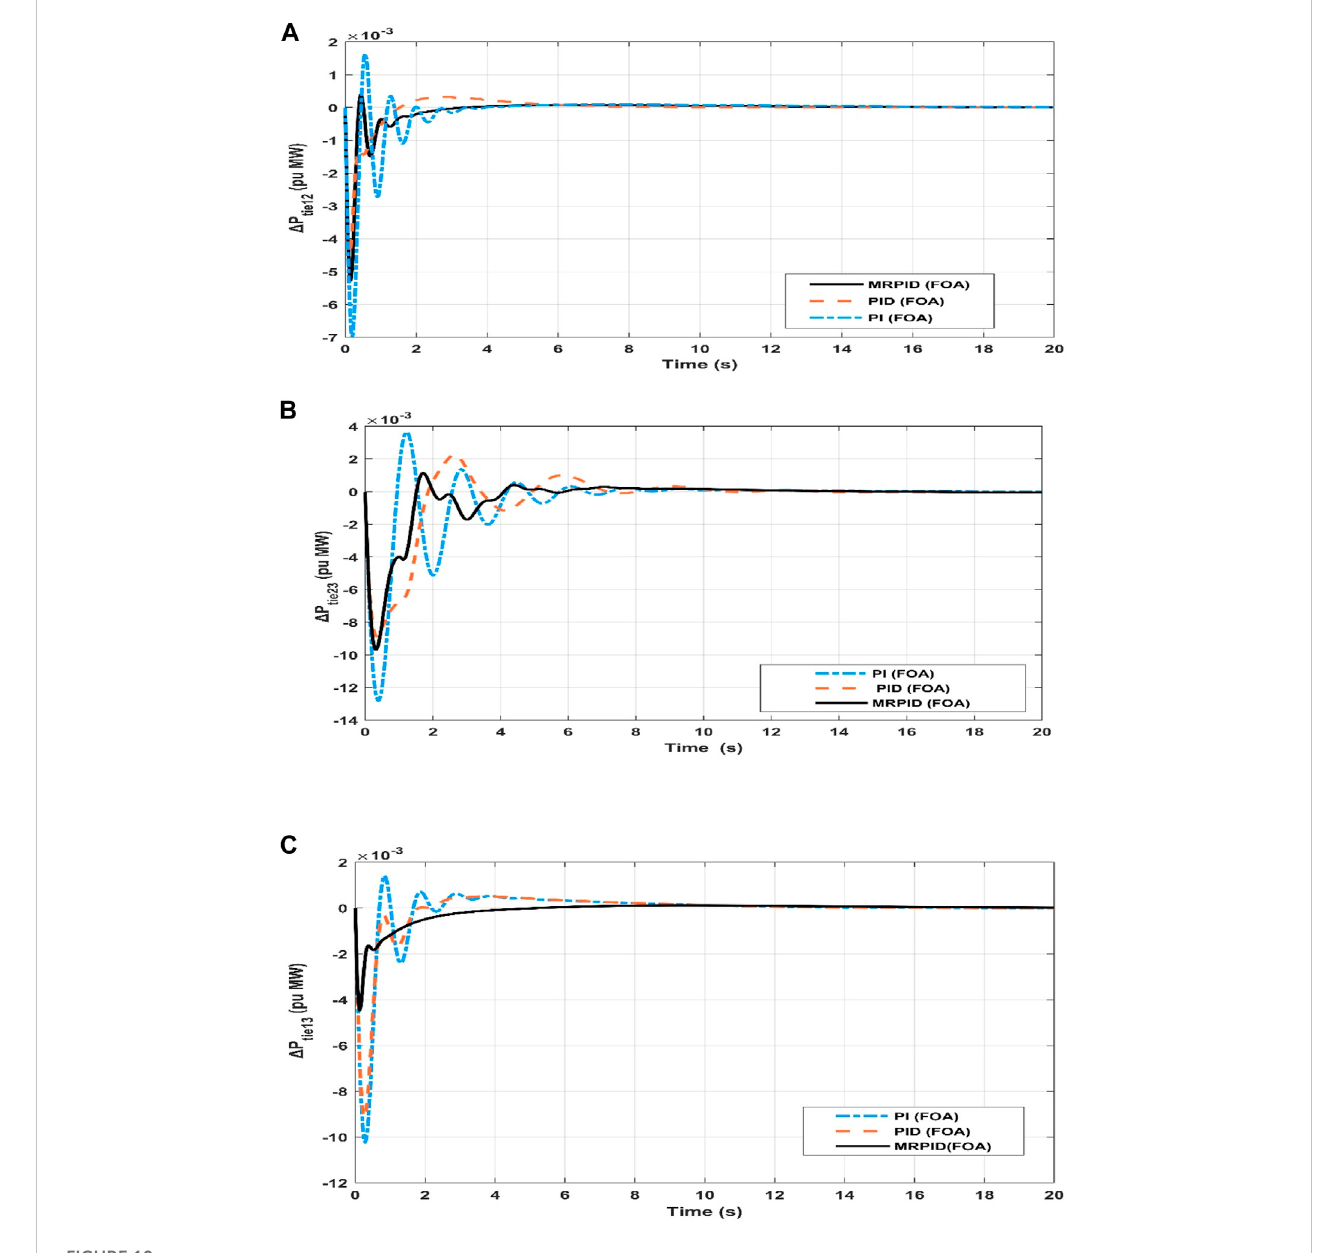
FIGURE 10 Response of the system for (A) Δ P tie12 (B) Δ P tie23 (C) Δ P